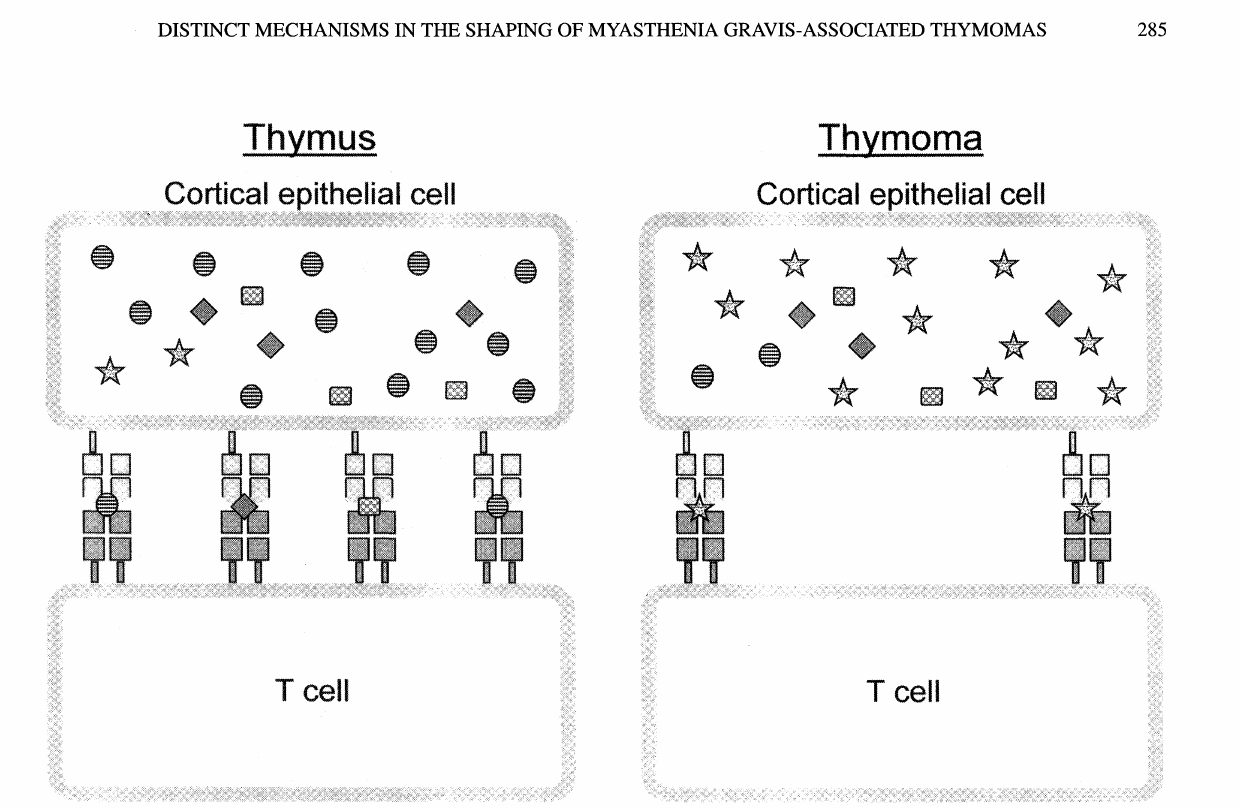
FIGURE 3 Hypothetical impact ofreduced epithelial class II expression on peptide presentation: only frequent peptides are displayed, while minor peptides fall below the threshold level required for positive selection (Grubin et al. 1997). Moreover, due to overexpression of tumor-related antigens, the peptide repertoire presented by epithelial cells in thymomas is most probably biased and not identical with the wild-type repertoire